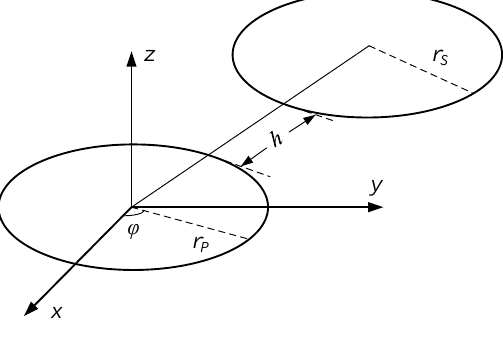
Figure 2. Schematic of coplanar coils.